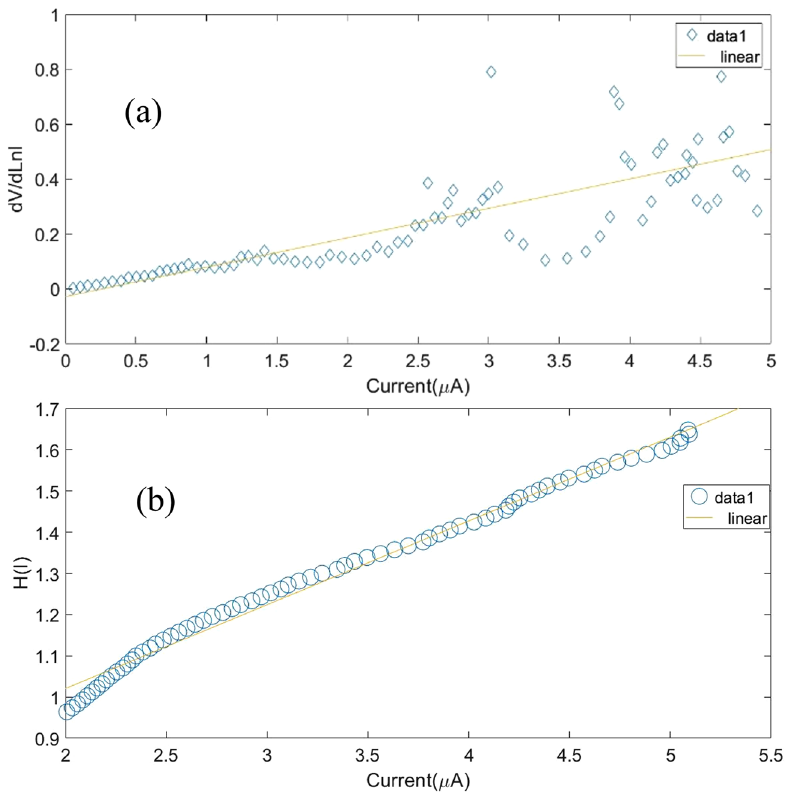
Figure 15. ( a ) dV/d(lnI)-I and ( b ) H(I)-I plots of NiO/Si heterojunction device at 300